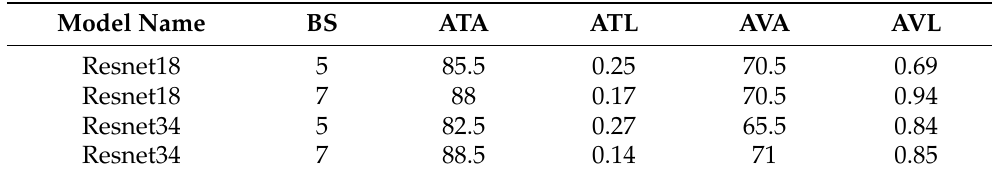
Table 6. Audio classifier results by BS.